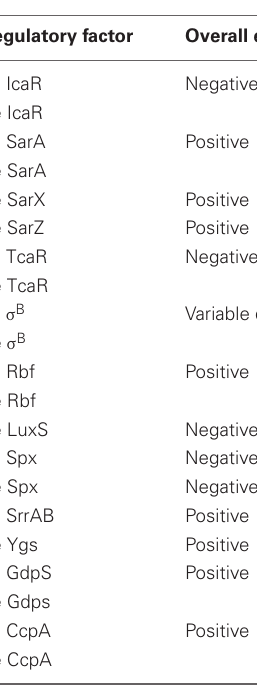
Table 1 | Regulatory proteins affecting icaADBC expression in